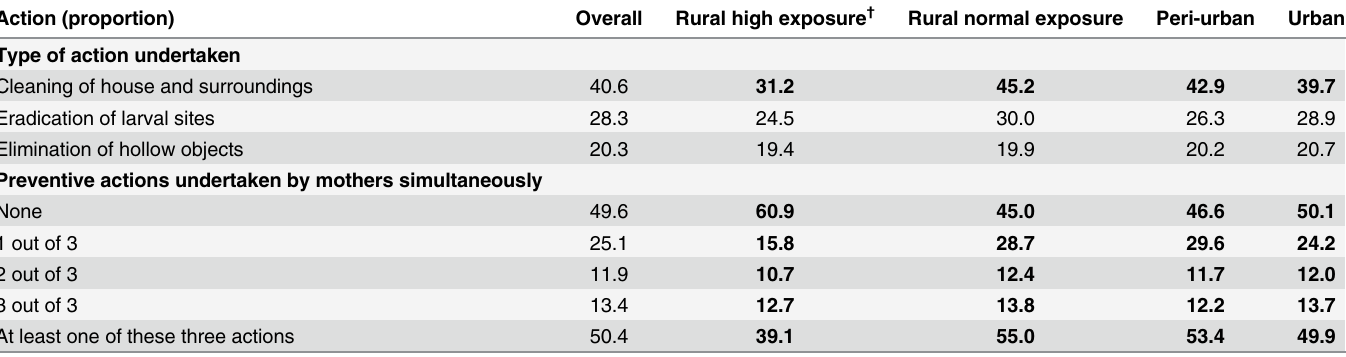
Table 3. Prevalence of larval control practices undertaken by mothers in the 2,004 households surveyed.